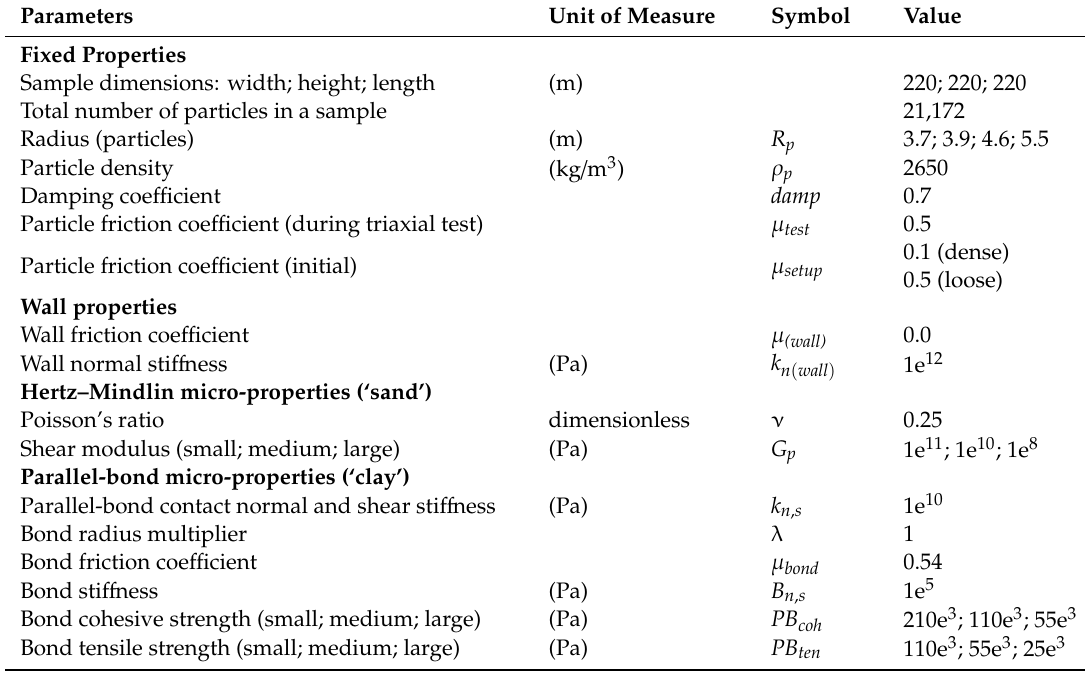
Table 1. Fixed and tested micro-parameters applied in each of the triaxial tests according to the contact model applied during the